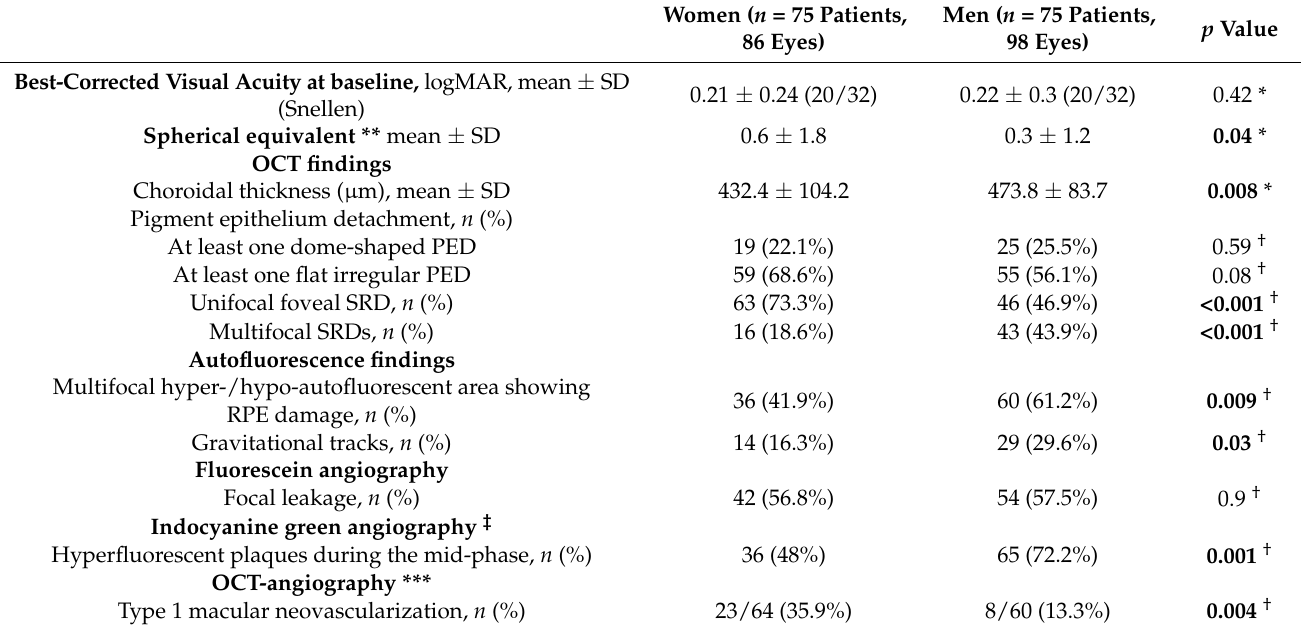
Women ( n = 75 Patients, Men ( n = 75 Patients, p Value 86 Eyes) 98 Eyes)